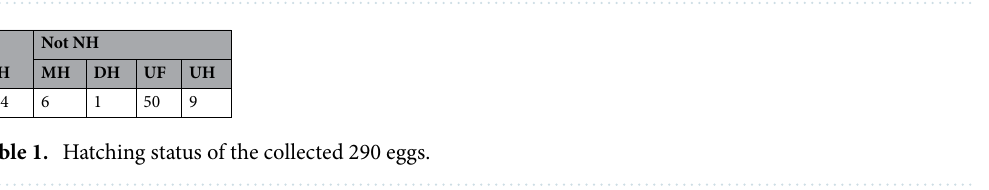
Figure 2. Examples of three types of the input egg images. Images focused on the ( a ) cytoplasm, ( b ) contour of the egg, and ( c ) oil droplet.